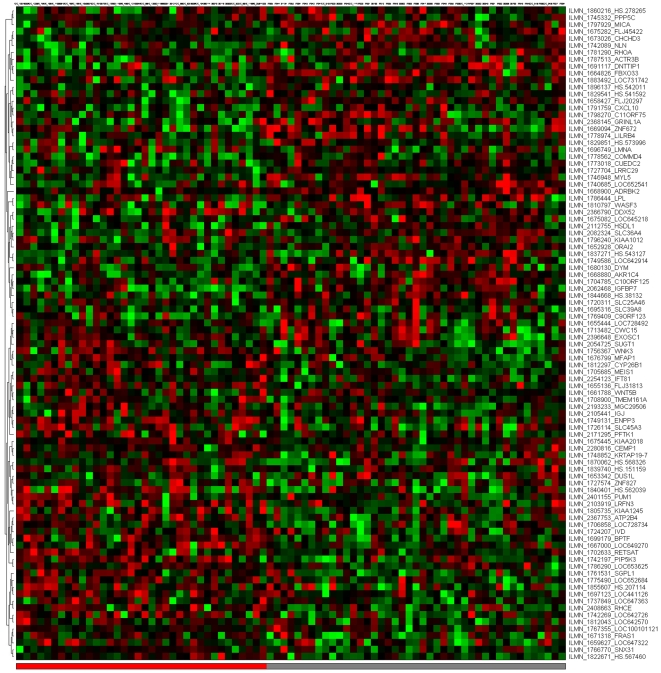
mRNA expression heatmap for the PP/RR signature.RRMS samples (red), PPMS (grey).